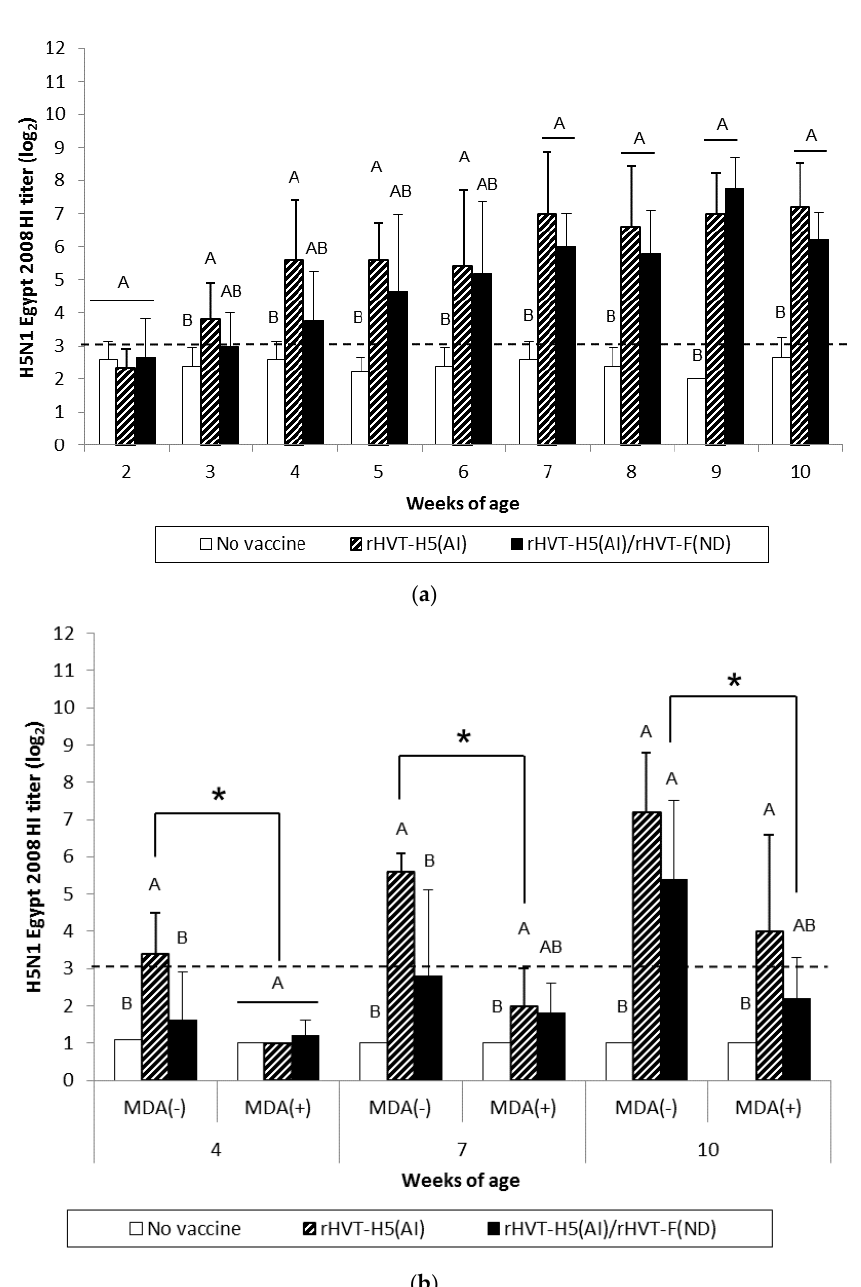
Figure 4. H5N1 Egypt 2008 HI titers in serum of WL SPF chickens ( a ) and LBL layer chickens ( b ) vaccinated at day-old (experiments I and II, respectively) with rHVT-H5(AI) or both rHVT-H5(AI) / rHVT-F(ND) vaccines. Data represent mean ± standard deviation (n = 5) of HI titers (log 2 ), which correspond to the last dilution exhibiting an inhibition of 4 hemagglutination units of A / Chicken / Egypt / 1709-6 / 2008 AIV HA antigens. HI geometric mean titers are expressed as reciprocal log 2 . Titers > 3 log 2 were considered positive (this threshold of positivity is indicated by the dotted line). In figure ( a ), mean ± standard deviation at time points with no common uppercase letters (A, B) indicates a significant difference between vaccination schedules ( p < 0.05). In figure ( b ), mean ± standard deviation at time points with no common uppercase letters (A, B) indicates a significant difference between vaccination schedules within the MDA group ( p < 0.05), while asterisk superscript symbol (*) indicates a significant difference between MDA(–) and MDA( + ) groups within a given vaccination schedule ( p <